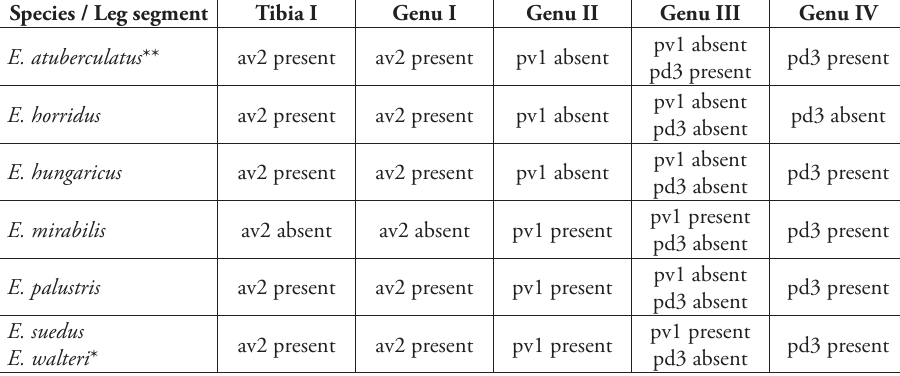
Table 3. Differences in leg chaetotaxy in species of Epicriopsis with known leg chaetotaxy [based on Halliday (1997)*, Narita and Moraes (2016)**, and own